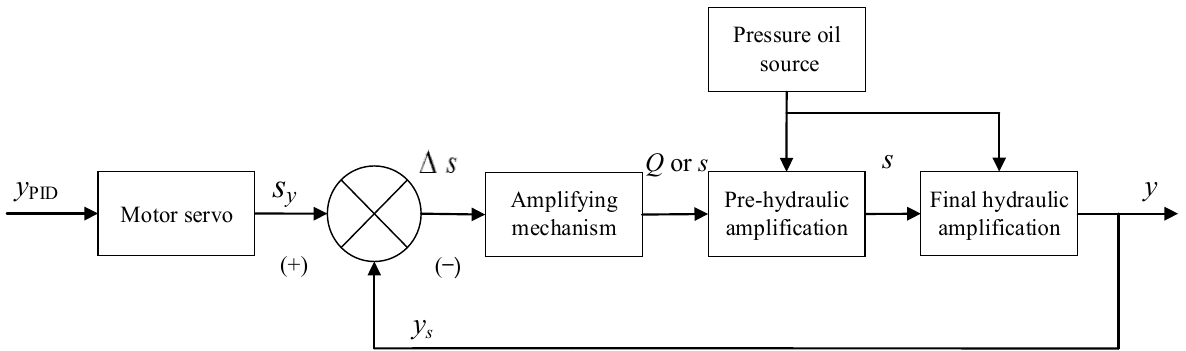
Figure 1. Schematic diagram of PID control system. Parameters K p , K i and K D represent the proportional-integral-differen- tial loop, and parameters b p , y and T y represent the difference coefficient, the guide vane opening, and the relay time constant, respectively.